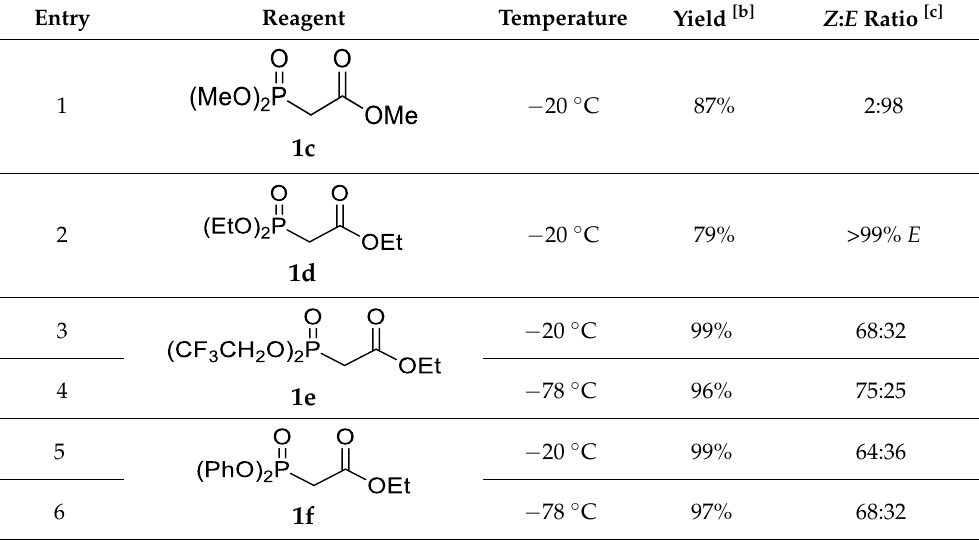
Table 2. HWE reaction of phosphonate reagents 1 and benzaldehyde 2a with (CF 3 ) 2 CHONa as a base [a] .